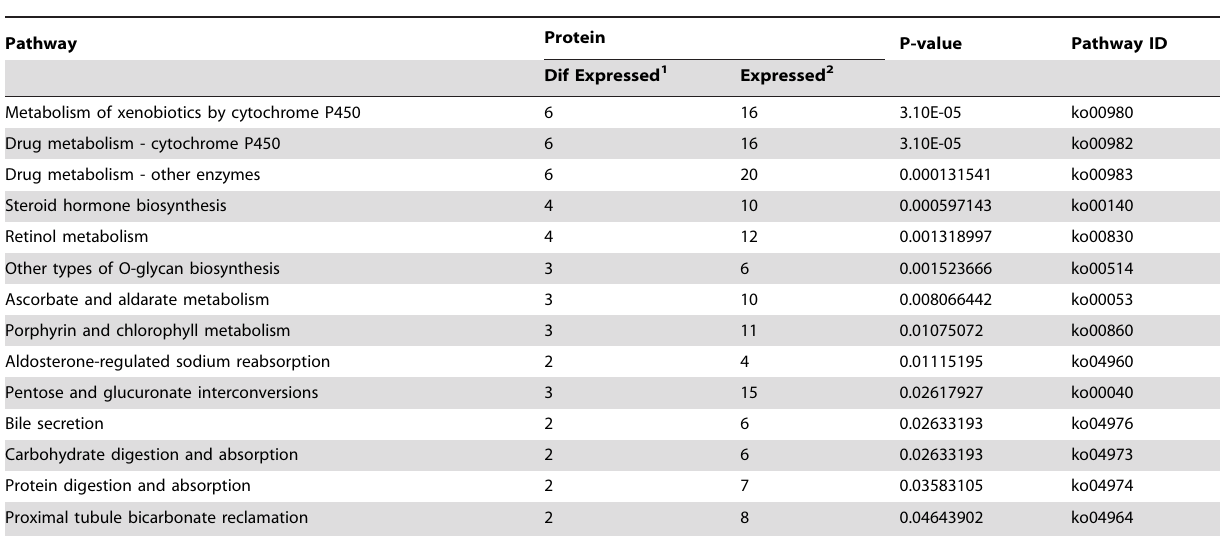
Table 4. Significantly enriched KEGG pathways in B. tabaci